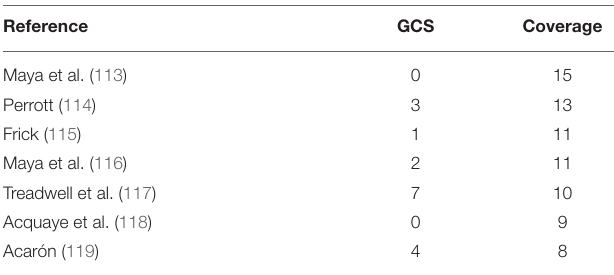
TABLE 8 | Citing papers belonging to cluster